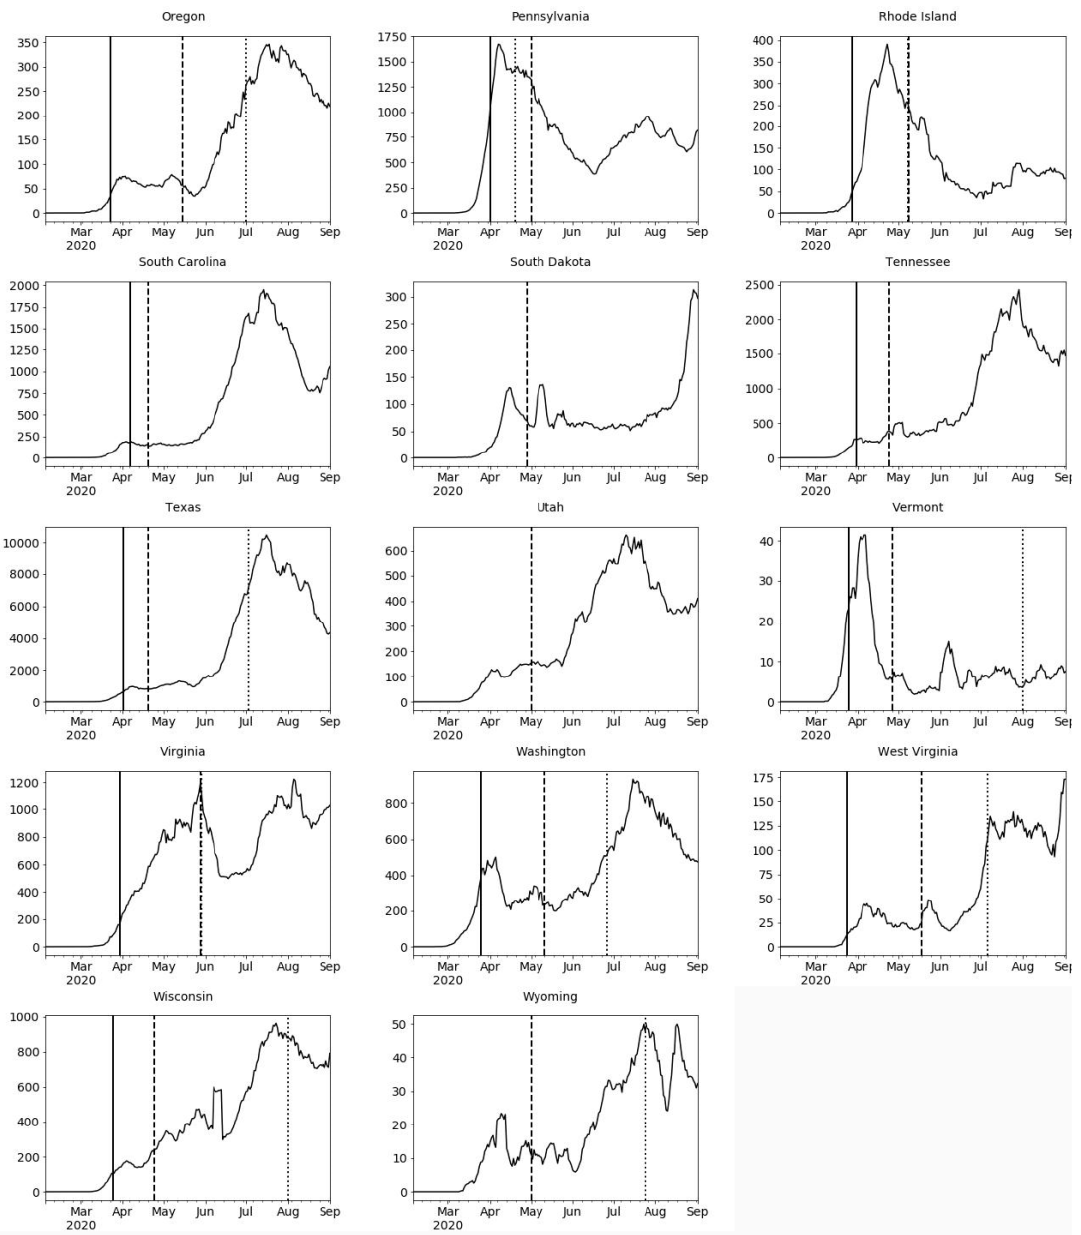
Figure A1. COVID-19 daily confirmed cases (7-day rolling average); US states. Source: author’s analysis of state policy using NY Times [1,26] and CNN data